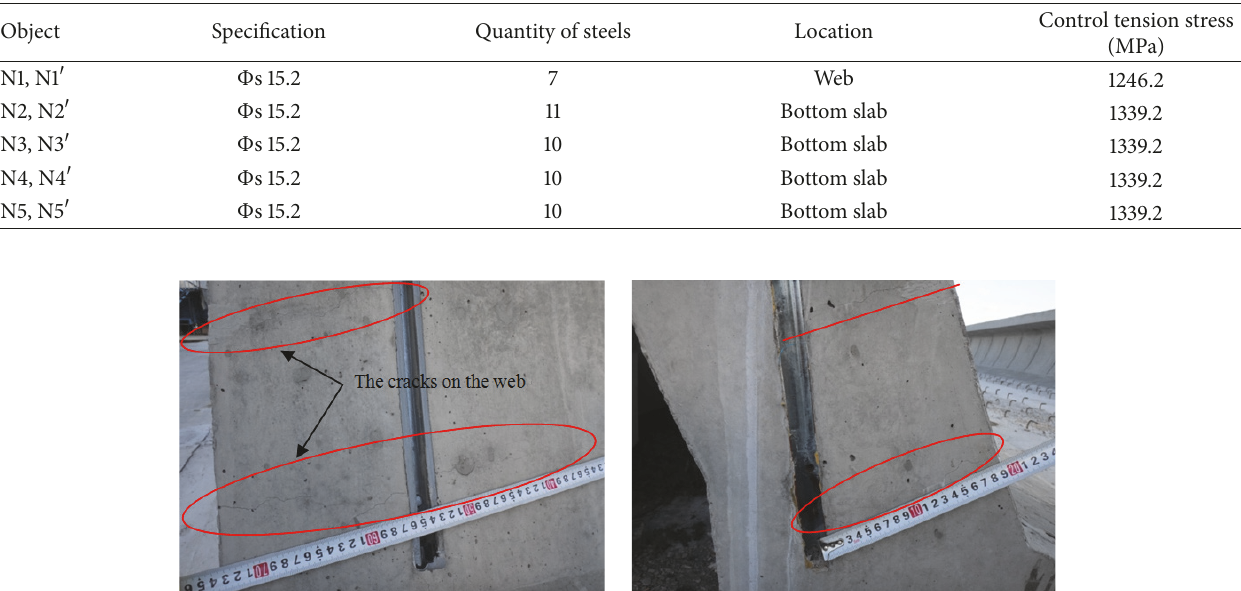
Table 1: Design parameters of prestressed steels.